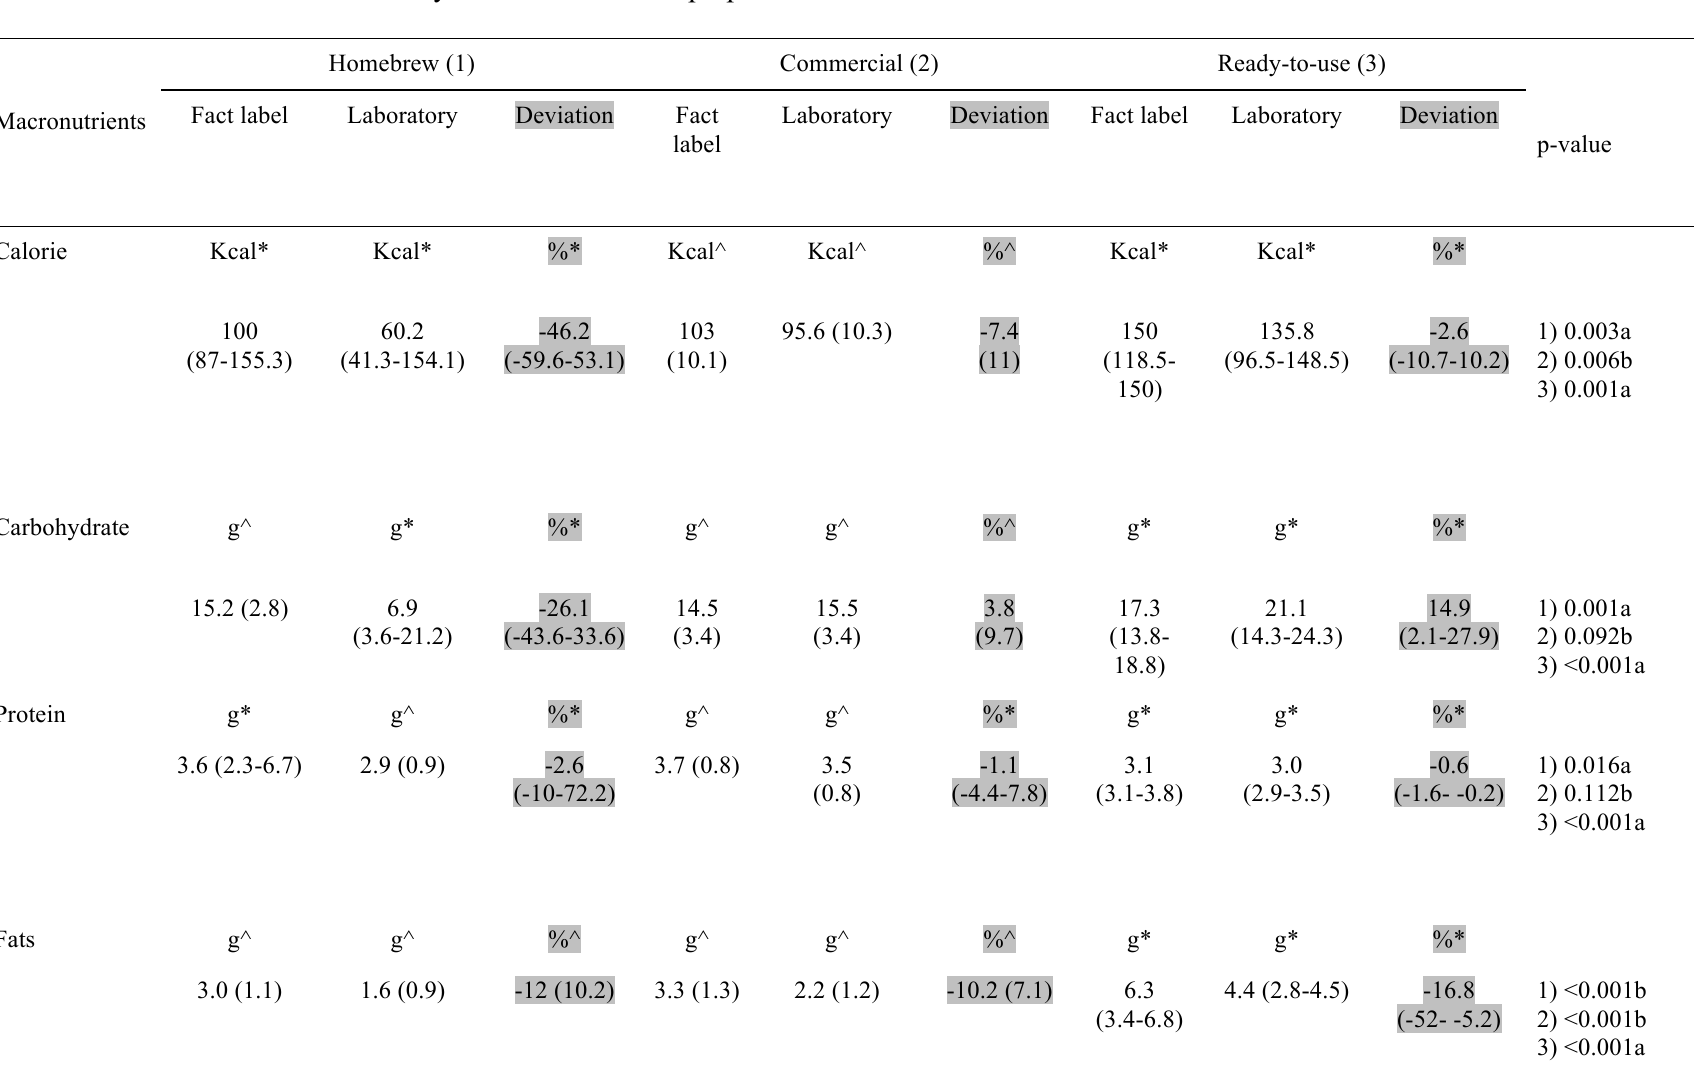
Table 1 Macronutrient level accuracy of different enteral preparation